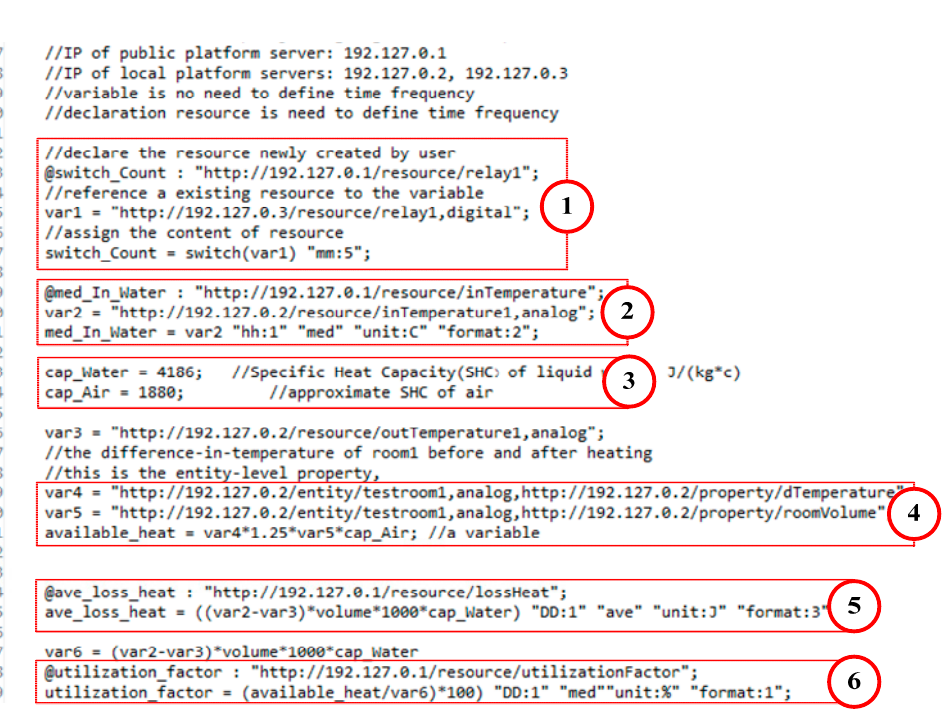
Figure 7. An example of DML from a heating scenario.